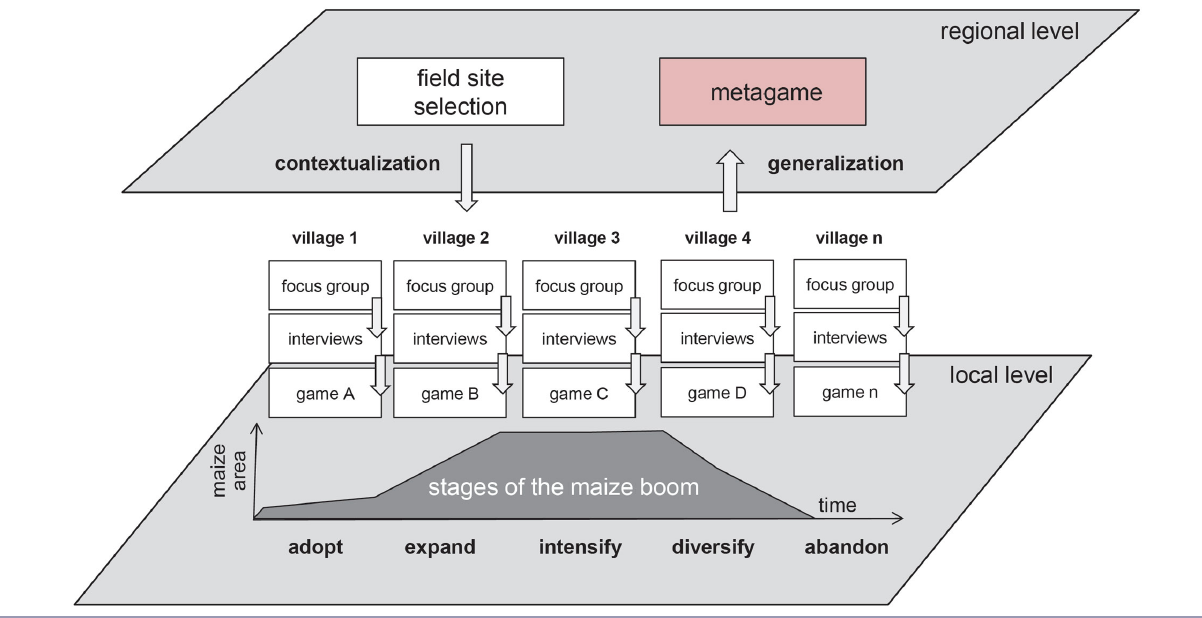
Fig. 1 . Multiscale gaming methodology. Systematic case study selection at the regional level is followed by field studies at the local level, which each represent different decision stages. Metagame represents the findings from the local level in a generalized form and can be validated in a serious game workshop with